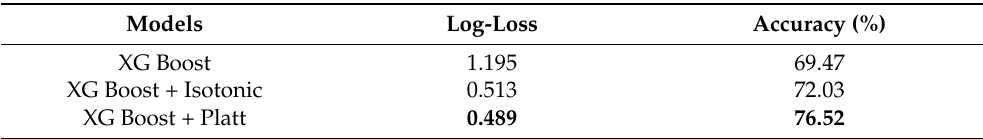
Table 12. Results after XG Boost classifier calibration with Isotonic Regression and Platt’s methods. The best scores are shown in